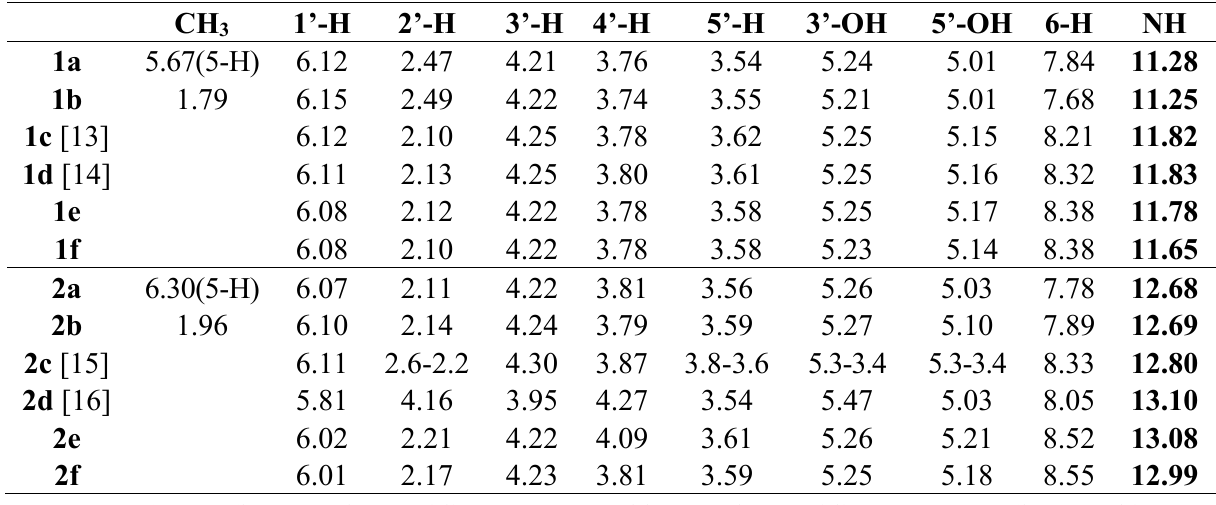
Table 1. 1 H-NMR of 5-Substituted-2’deoxyuridines and their 4-thioanalogues (in DMSO- d